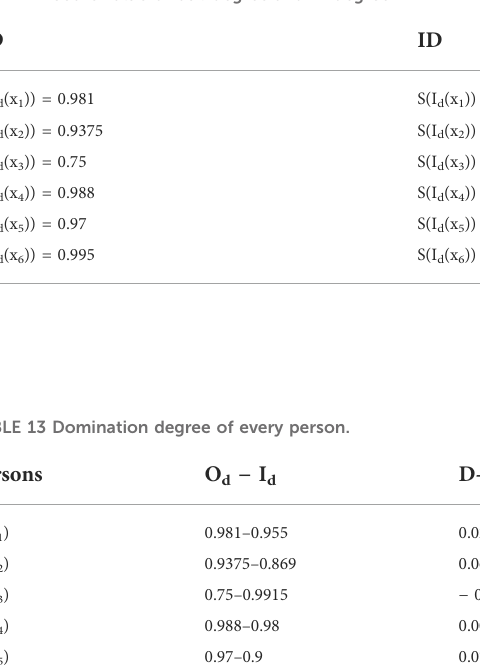
TABLE 12 Score value of out-degree and in-degree.